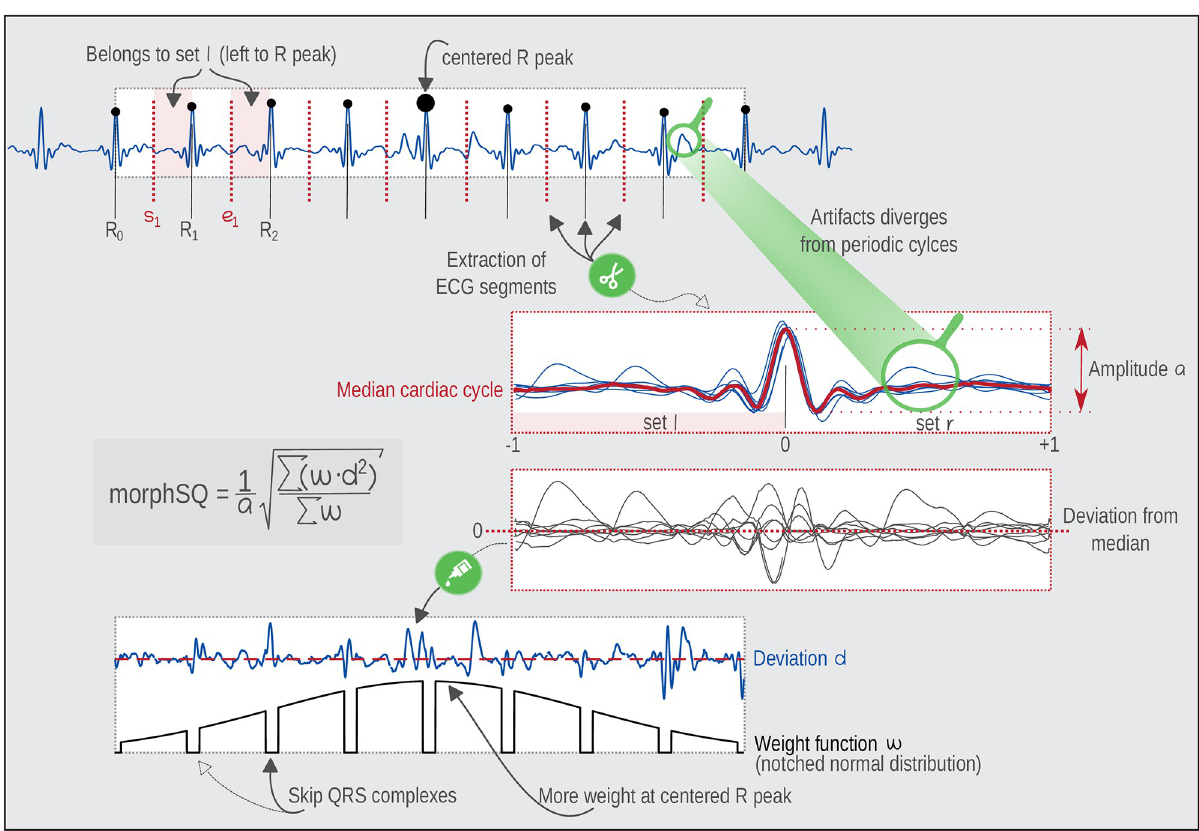
Fig 2. Illustration of the morphological signal quality process in a sliding window of an ECG (number of cardiac cycles k = 8).